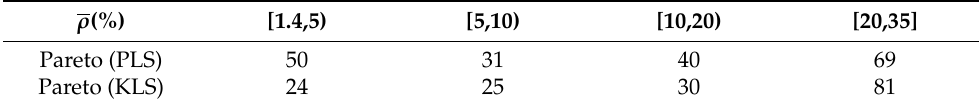
Table 7. The distribution for Pareto solutions of ρ for Op-II.